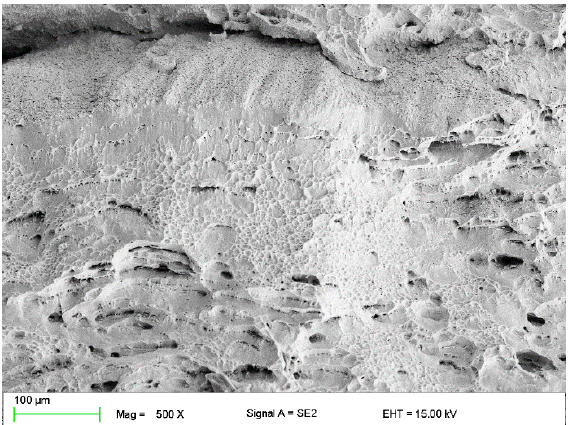
Figure 9. The fracture surface of the sample annealed at 1200 ◦ C, showing interactions between the formed macrovoids and numerous non-metallic inclusions.